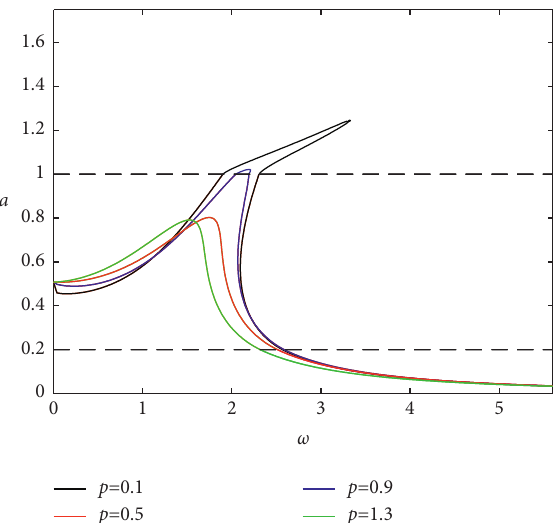
Figure 5: Amplitude frequency response curve with the order of fractional differential term.